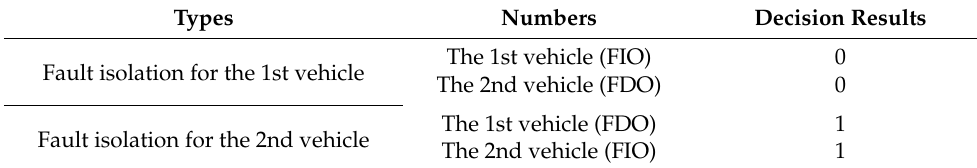
Table 2. Fault isolation logic.